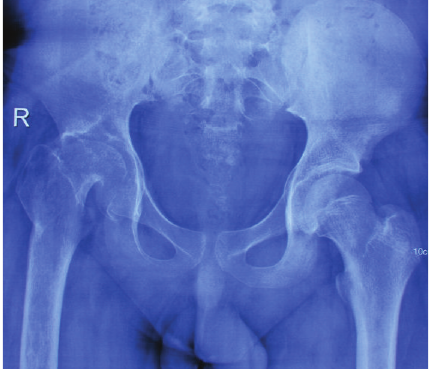
Figure 5: Resected part of the large bowel with appendix and caecum.